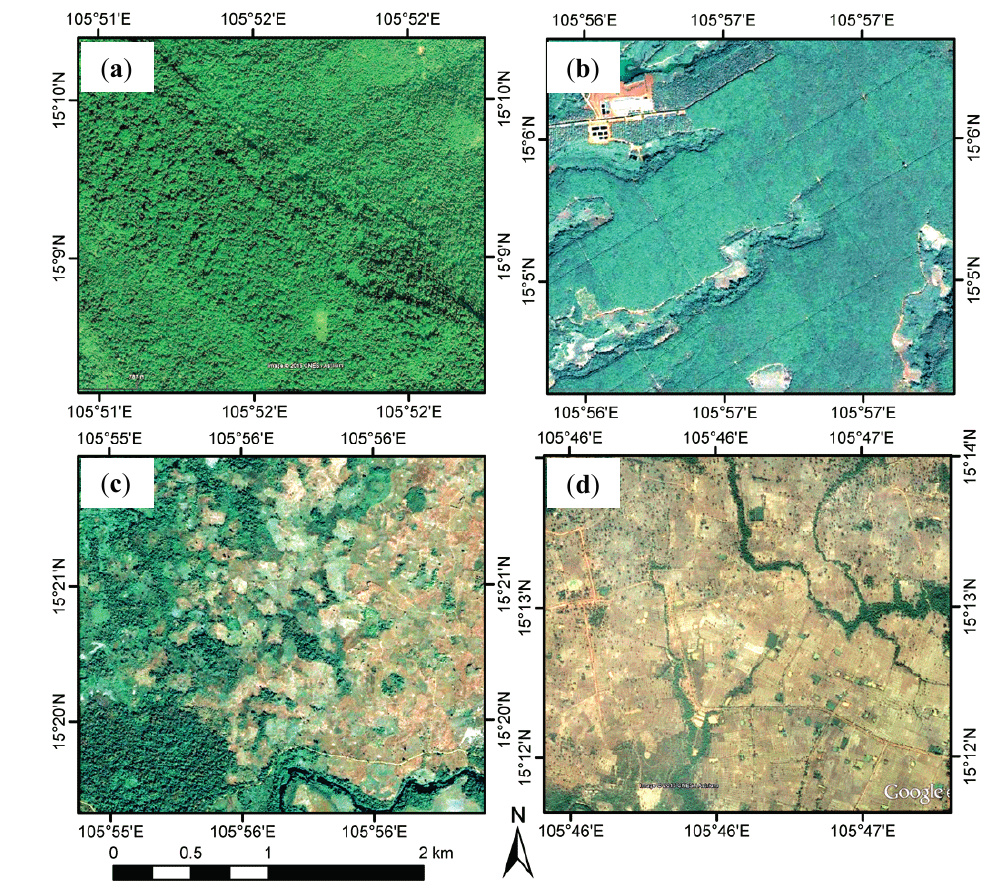
Figure 3. Google Earth TM images in 2012 representing the four land covers: ( a ) native forest, ( b ) rubber plantation, ( c ) mixed wooded/cleared area, and ( d )